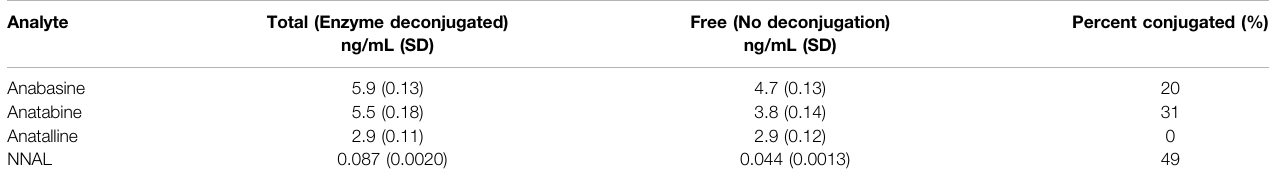
TABLE 6 | Concentrations of anabasine, anatabine, anatalline, and NNAL in pooled smokers ’ urine, with and without deconjugation using β -glucuronidase. Mean of 6 replicate analyses using Method 2. 1